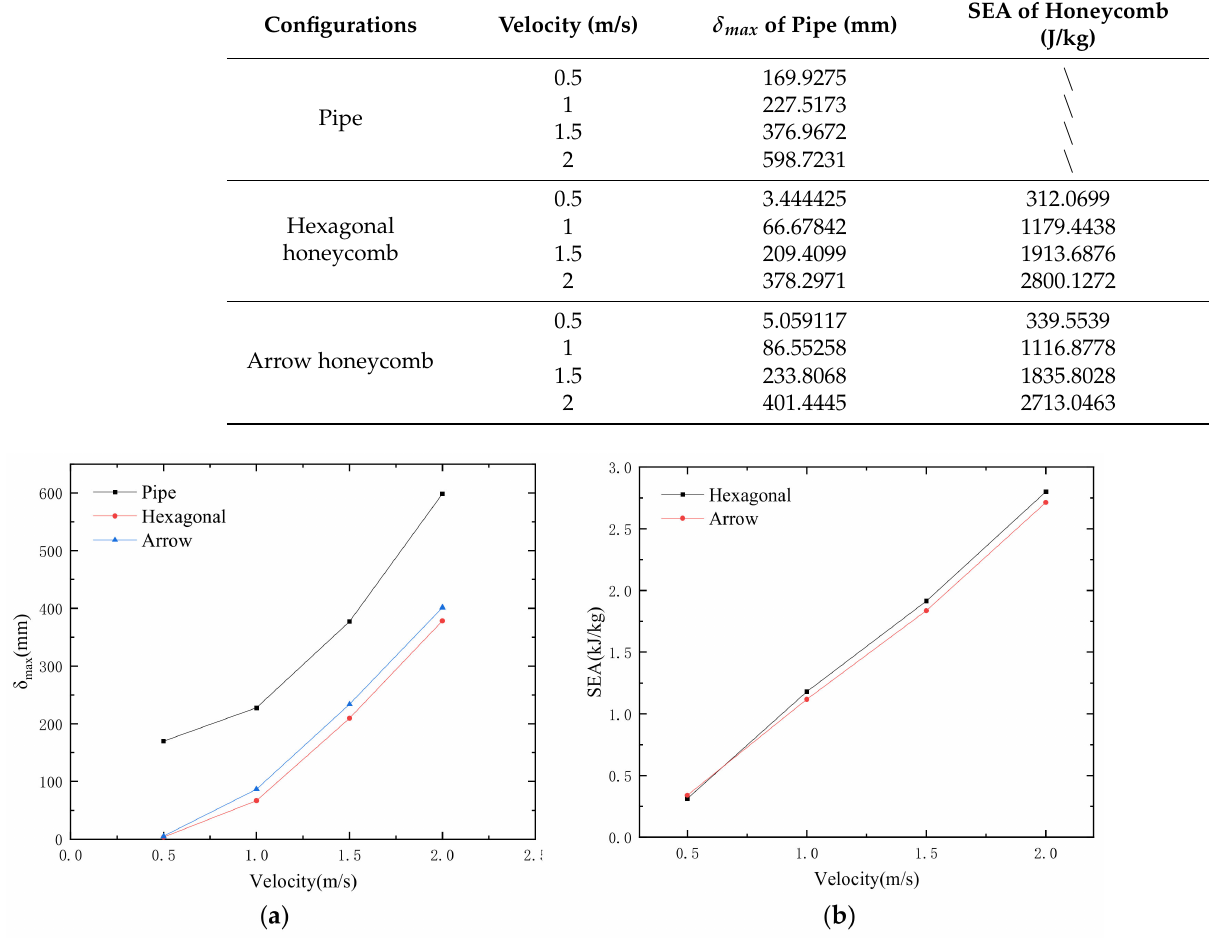
Figure 18. Crashworthiness index—velocity curves. ( a ) δ max –velocity curve; and ( b ) SEA–velocity